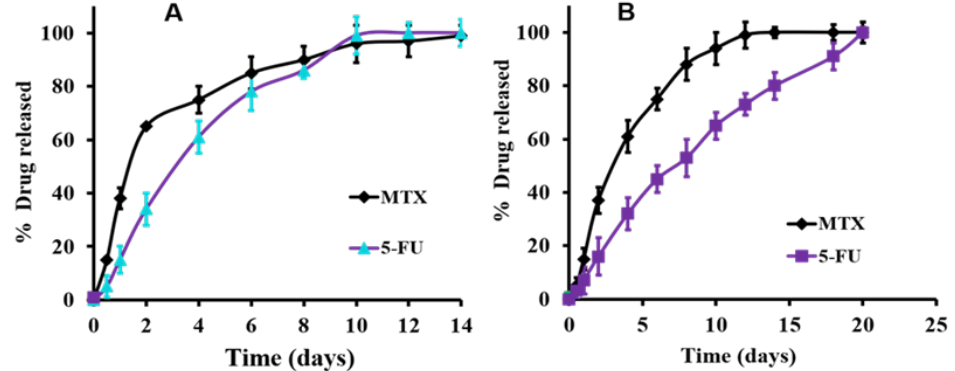
Figure 3. In vitro release profiles of both 5-FU and MTX from ( A ) hydrogel formula A, composed of 30%, w / v 8armPEG-chol/8rmPEG-CD (1:1%, w / w ratio), and from ( B ) hydrogel formula C, composed of 10%, w / v 8armPEG20k-chol/p β -CD (1:1%, w / w ratio) at 37 °C in PBS.